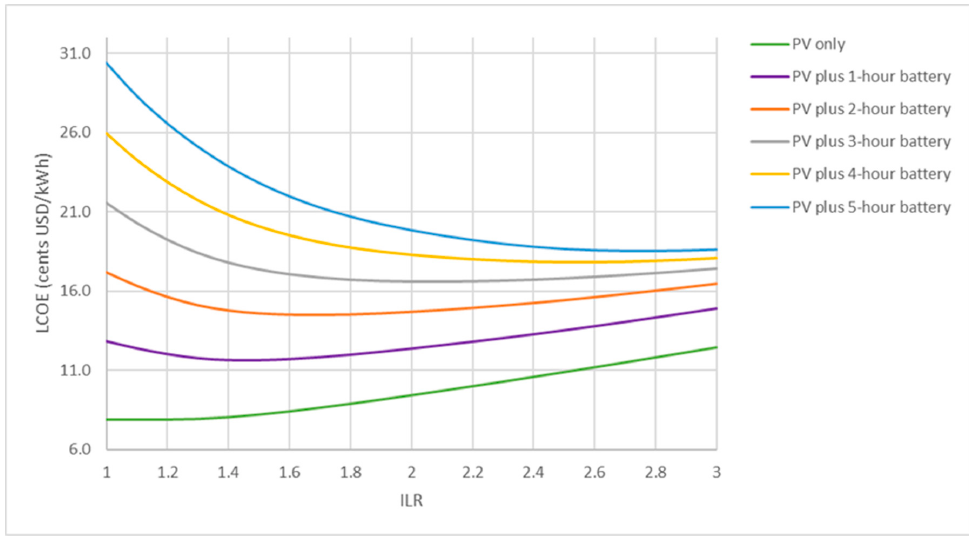
Figure 5. Variation of LCOE with ILR for fixed-tilt system.